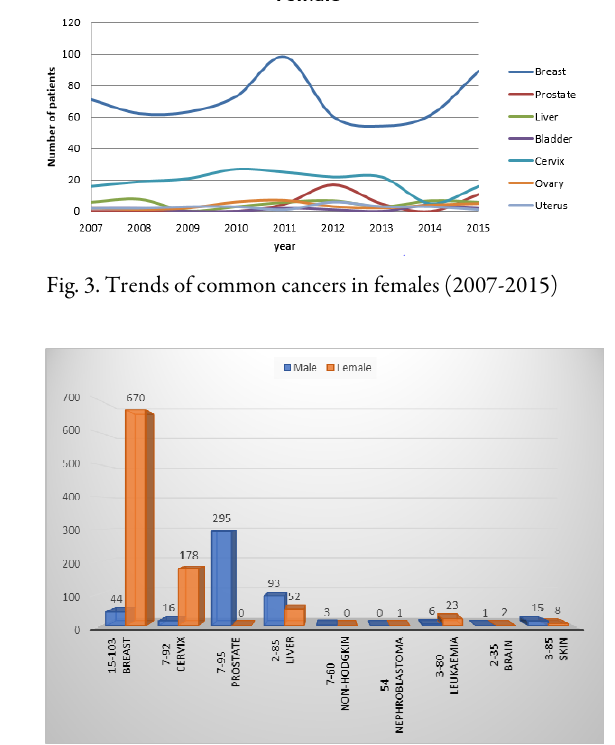
Fig. 5. Age characteristic of some selected cancer groups in Nigeria from the Ilorin